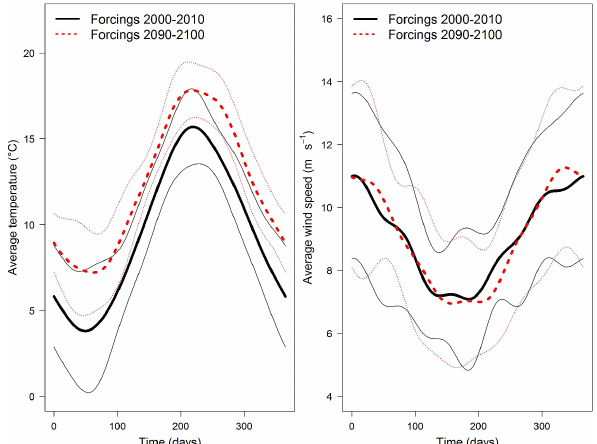
Fig. 7. Comparison between present climate forcings (2000–2010) (black solid line) and future climate forcings (2090–2100) (red dot- ted line) for air temperature (left) and wind speed (right). The daily averaged value of the 16 different climate simulations for a period of 10yr is plotted together with the 95% confidence